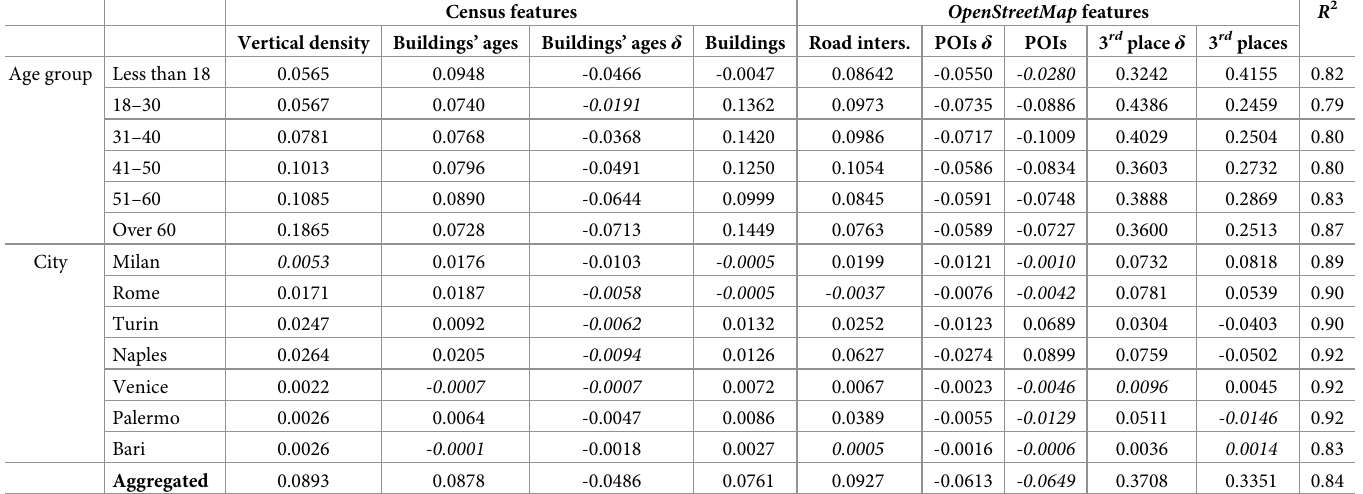
Table 3. Investigating the spatial relationship between urban features and vibrancy. We model the relationship between the presence of people and urban features by constructing a series of multivariate spatial models to account for spatial correlations present in the data. Here, we present the results of these models when considering all cities together. The table shows the values of the model coefficients, and values are reported in italic and small font size if they are not significant after fdr correction ( p > 0.05). The last column reports the Nagelkerke pseudo R square value, which provides a measure of how good the model is compared to a null model and has a similar interpretation to a traditional regression R 2 . Results for the individual cities are presented in S1 and S2 Tables in S1